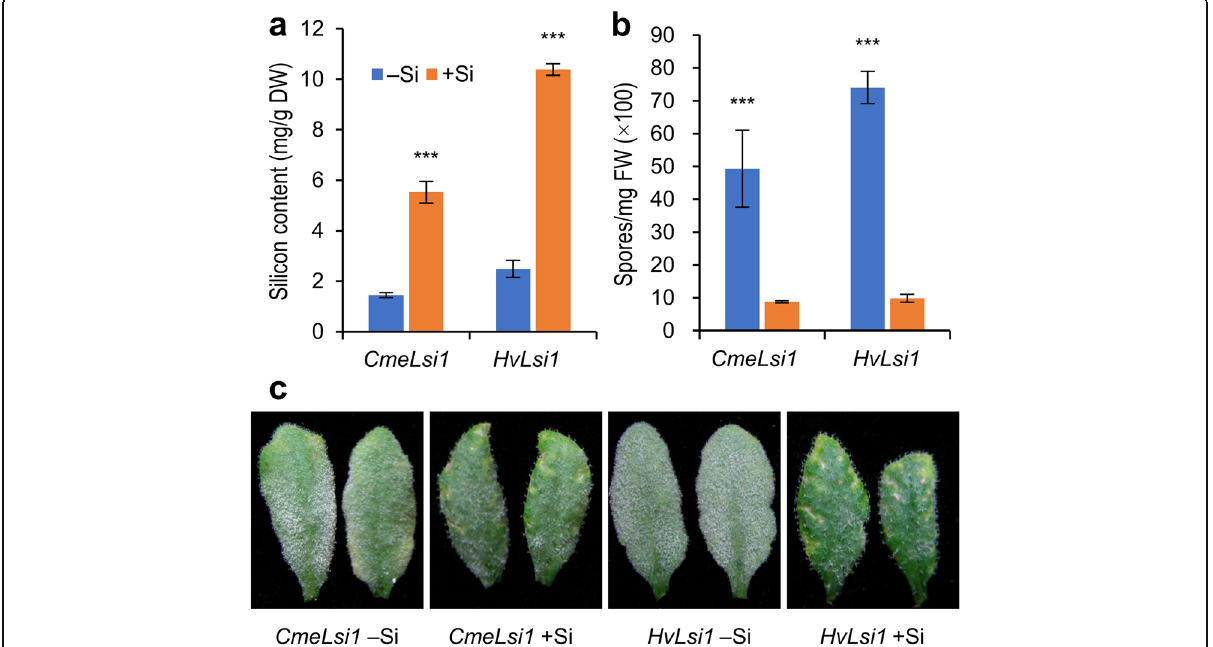
Fig. 2 Transgenic Arabidopsis plants with high leaf Si content display enhanced resistance against powdery mildew. a Silicon content in leaves of transgenic Arabidopsis CmLsi1 /Col-0 or HvLsi1 /Col-0 plants grown in perlite supplemented with 0mM ( − Si) or 1.0mM (+Si) silicon. b Quantification of spore production in the infected leaves of the plants in (a). c Representative Gc UCSC1-infected leaves of the indicated transgenic Arabidopsis Col-0 plants. Pictures were taken at 10 dpi. Error bar indicates SE based on 4 replicates, and asterisks denote significant difference (Student t -test, *** P